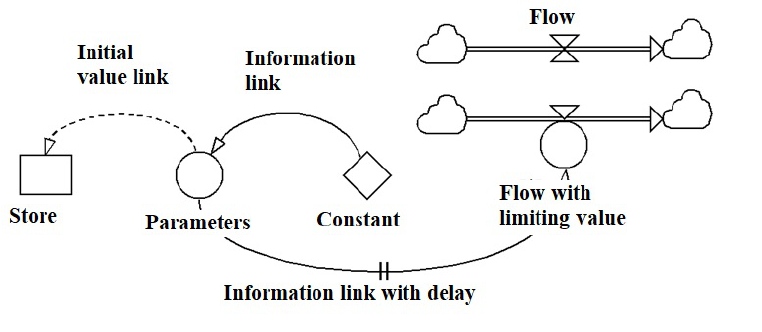
Fig. 1. Main elements that are used to build a model with Powersim